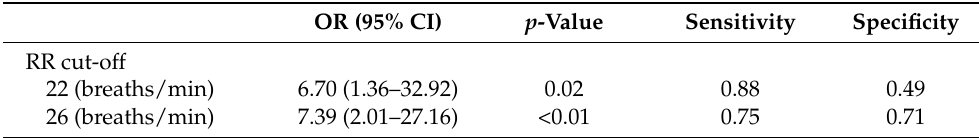
Figure 3. ROC curve for fraction of inspiratory oxygen (FiO 2 ). Table 7. Cut-off value for respiratory rate and clinical